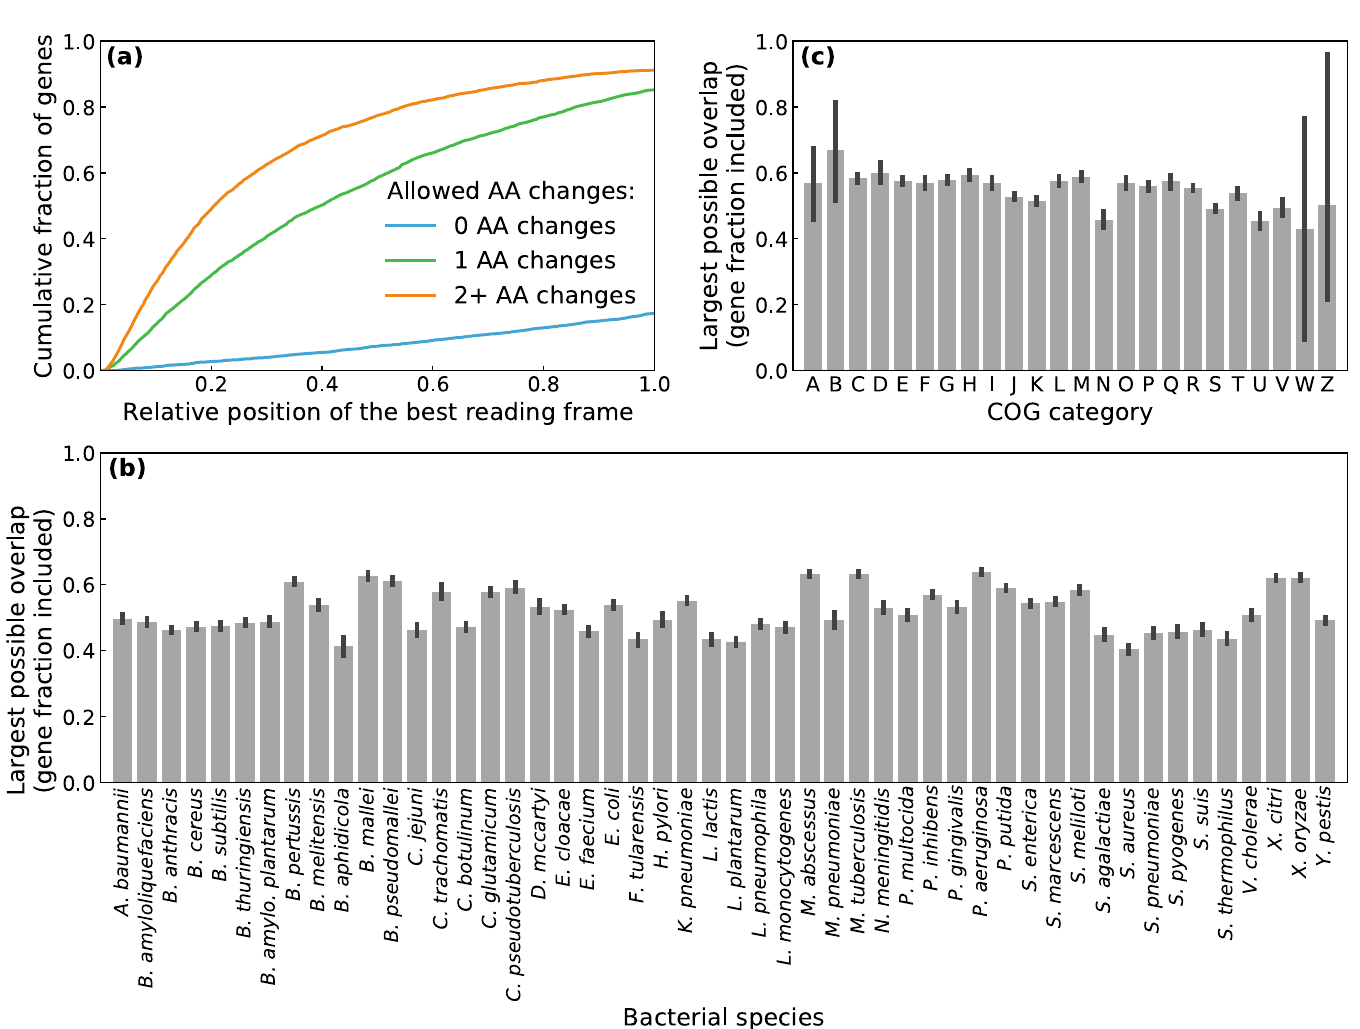
Fig 3. Large overlapping reading frames can be created in many genes. (a) Potential Riboverlaps in E. coli : cumulative distribution of the first position at which an overlapping reading frames can be created, for all genes of E. coli MG1655. Different colors represent different levels of stringency: 0 (blue), 1 (green), or 2 (red) amino acid changes allowed. (b) Potential Riboverlaps in other bacterial species: relative size of the largest overlapping frame that can be created. All coding sequences of each organism are averaged, and intermediate level of stringency (1 AA change) was chosen. Error bars represent 95% confidence intervals for all coding sequences of the focal organism. (c) Potential Riboverlaps in all COG (Cluster Of Genes) categories. Pooling the 156,542 coding sequences of 50 bacterial species, average relative size of the largest overlapping frame can be created, for each COG category. Error bars represent 95% confidence intervals for all proteins attributed to the focal functional